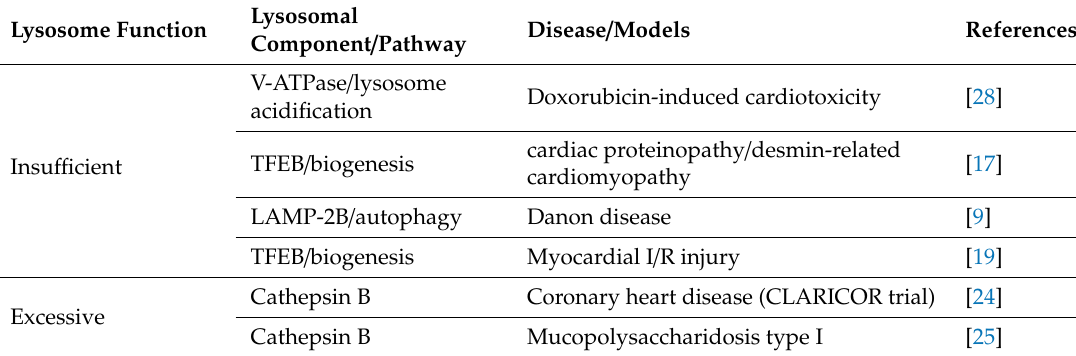
Table 1. Recent studies on lysosome dysfunction in cardiovascular